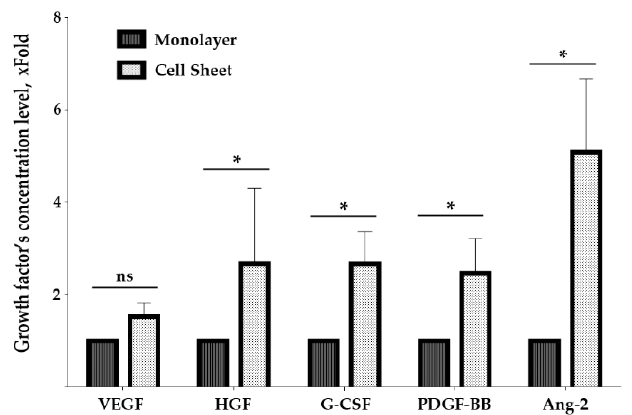
Figure 6. Changes of growth factors production by MSC in cell sheet and monolayer culture. Graph demonstrates assayed protein concentration change expressed as fold increase vs. monolayer culture; data presented as Median (25;75); *— p < 0.05, Mann–Whitney.